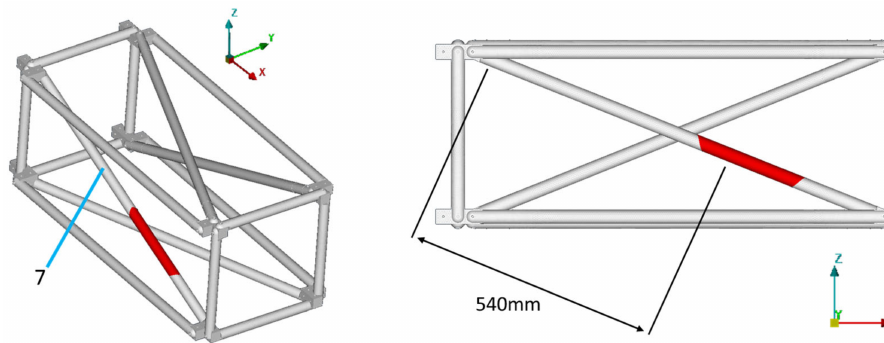
Figure 22. D7: Damaged FE model.